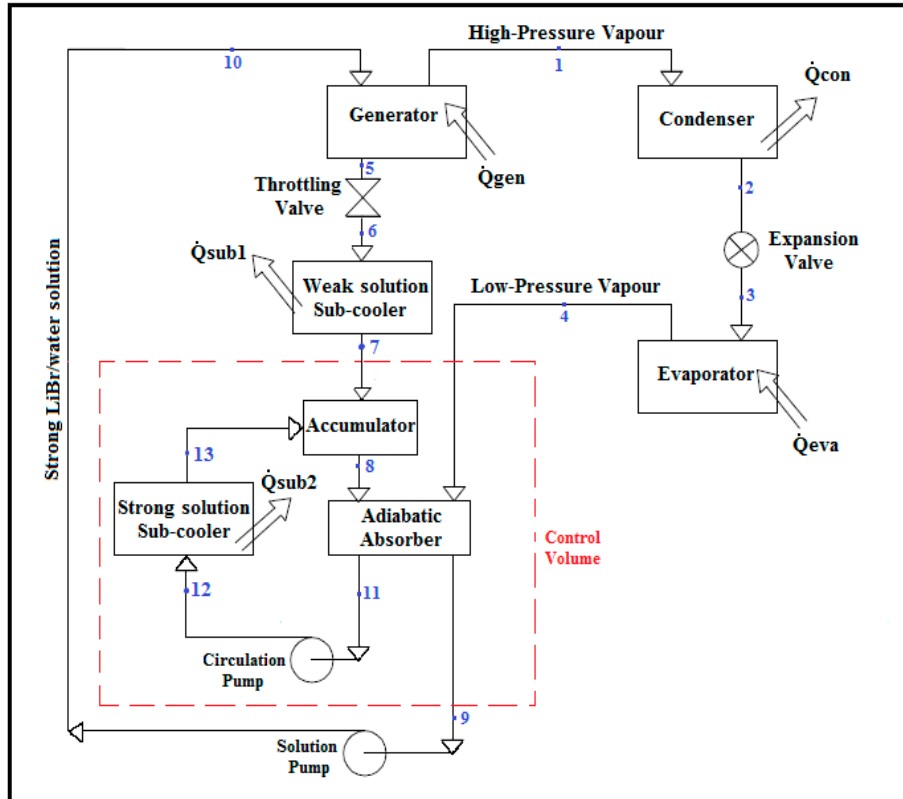
Figure 1. Schematic diagram of a LiBr/water (lithium-bromide/water) absorption refrigeration system equipped with an adiabatic absorber.